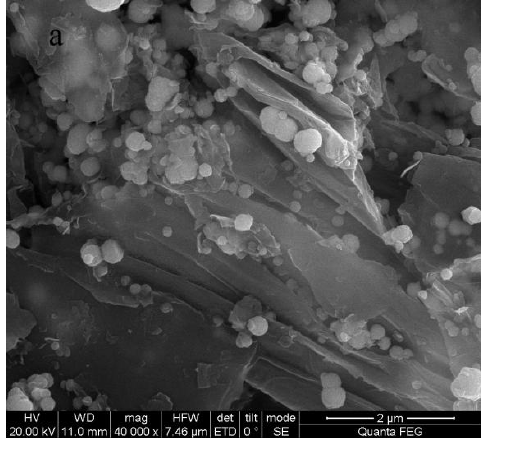
Figure 4. XRD spectra of graphene oxide (GO), Fe–Mn and Mn-doped Fe/rGO.